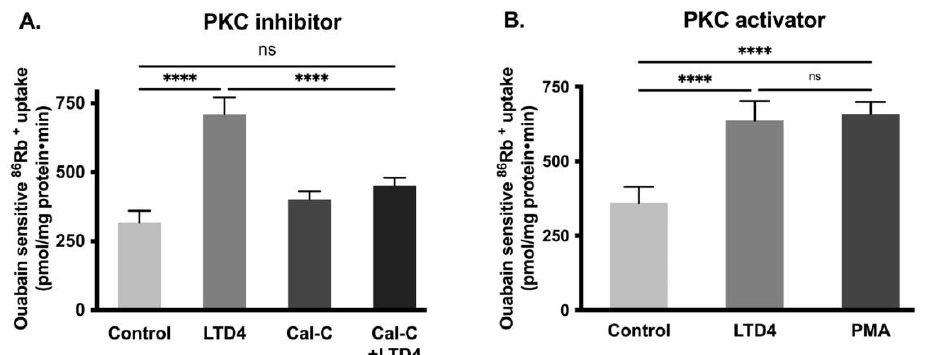
Figure 5. Effect of Protein kinase C (PKC) inhibitor and activator on Na-K-ATPase activity in IEC-18 cells after 24 h. ( A ) PKC inhibitor calphostin-C (0.1 µM). ( B ) PKC activator PMA (1 µM). Measurement of Na-K-ATPase activity by 86 Rb+ uptake. Values are represented as means ± SEM ( n = 6, Tukey’s multiple comparisons test). **** p < 0.0001 vs. control; ns., not significant.